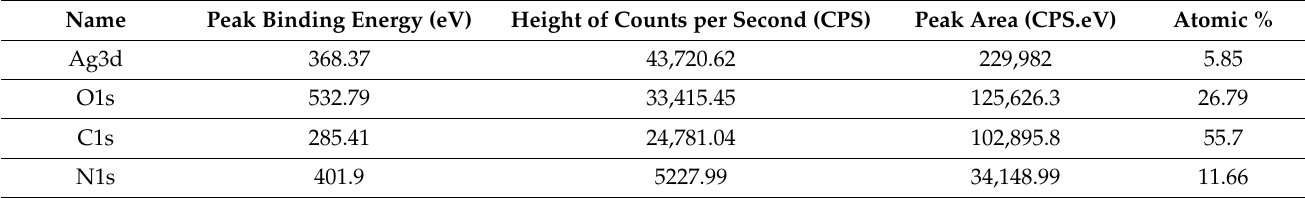
Figure 3. SEM image of concentrated (~2300 ppm ( a ) and diluted (~50 ppm) ( b ) silver nanocomposites; ( c ) TEM images of nanocomposites at higher magnification; ( d ) the size distribution analysis of as-synthesized silver nanocomposites, determined by ImageJ; ( e ) EDS pattern of synthesized silver nanocomposites; and ( f ) XPS pattern of the synthesized silver nanocomposites. Table 3. Detailed summary of the elemental composition of silver nanocomposites.